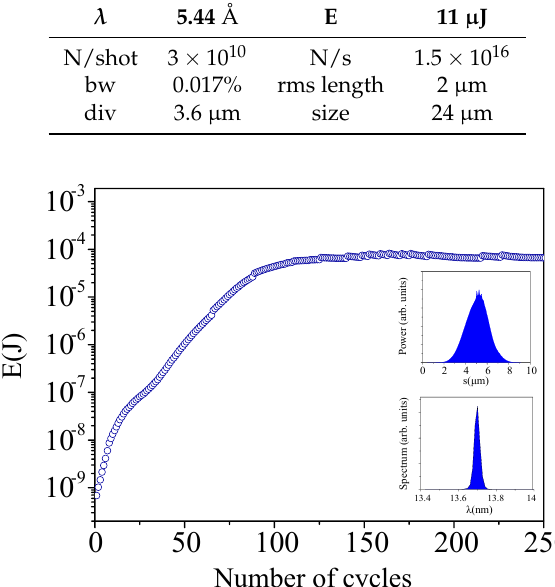
Figure 5. Intracavity energy vs number of cycles. In the boxes: radiation amplitude and spectrum at saturation.